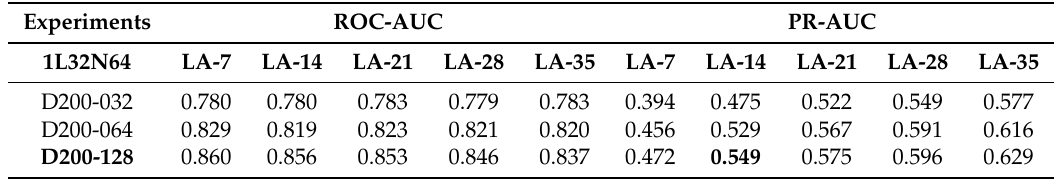
Table 4. ROC and PR as the test results of one layer LSTM with various timesteps. Experiments ROC-AUC